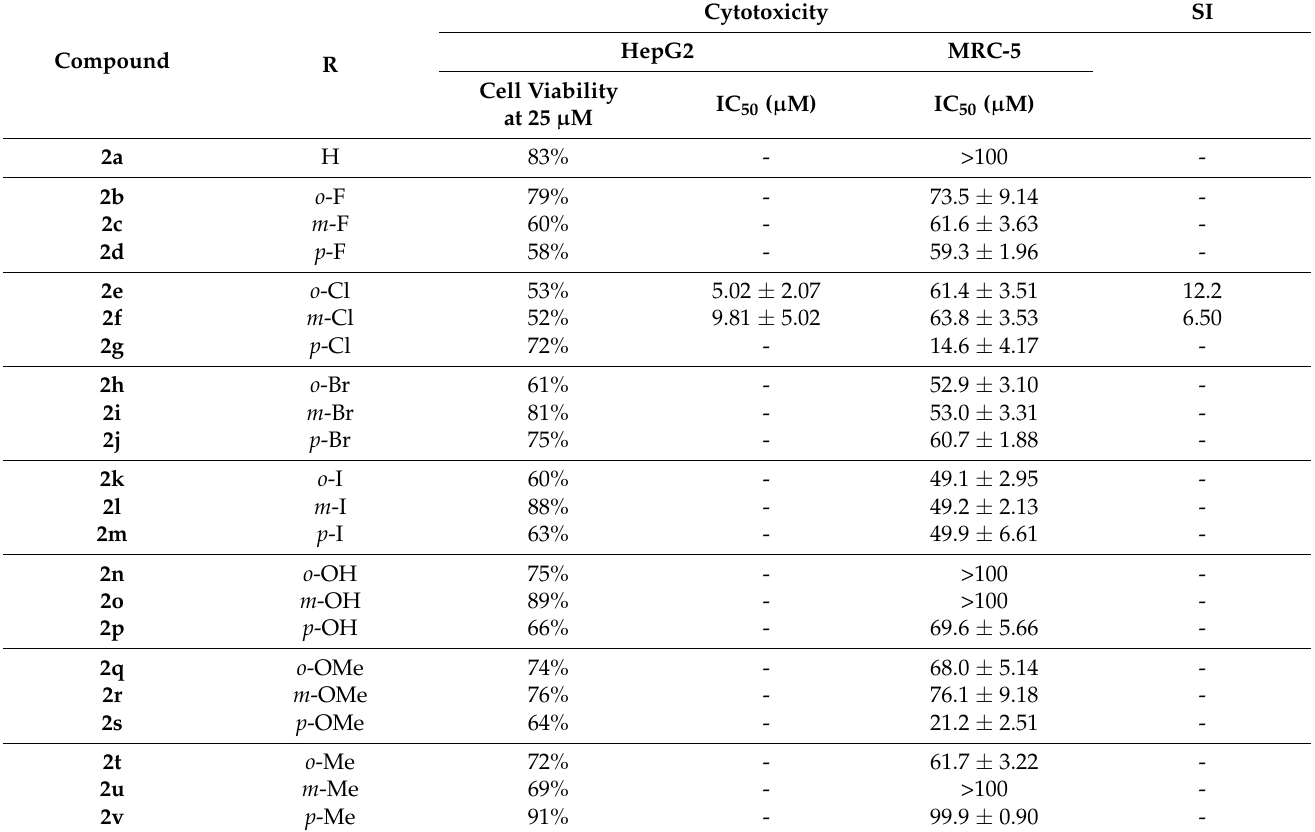
Table 1. In vitro cytotoxicity toward HepG2 and MRC-5 of the synthesized triazole derivatives, indicated as cell viability percentage at 25 µ M and half-maximal inhibitory concentration (IC 50 ) at a µ M scale. The selectivity index (SI) was